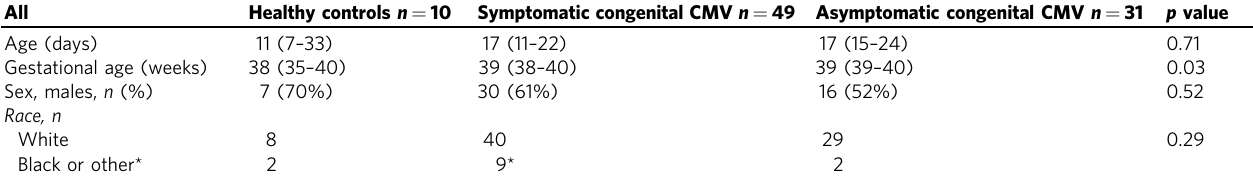
Table 1 Demographic data of healthy controls and infants with congenital CMV